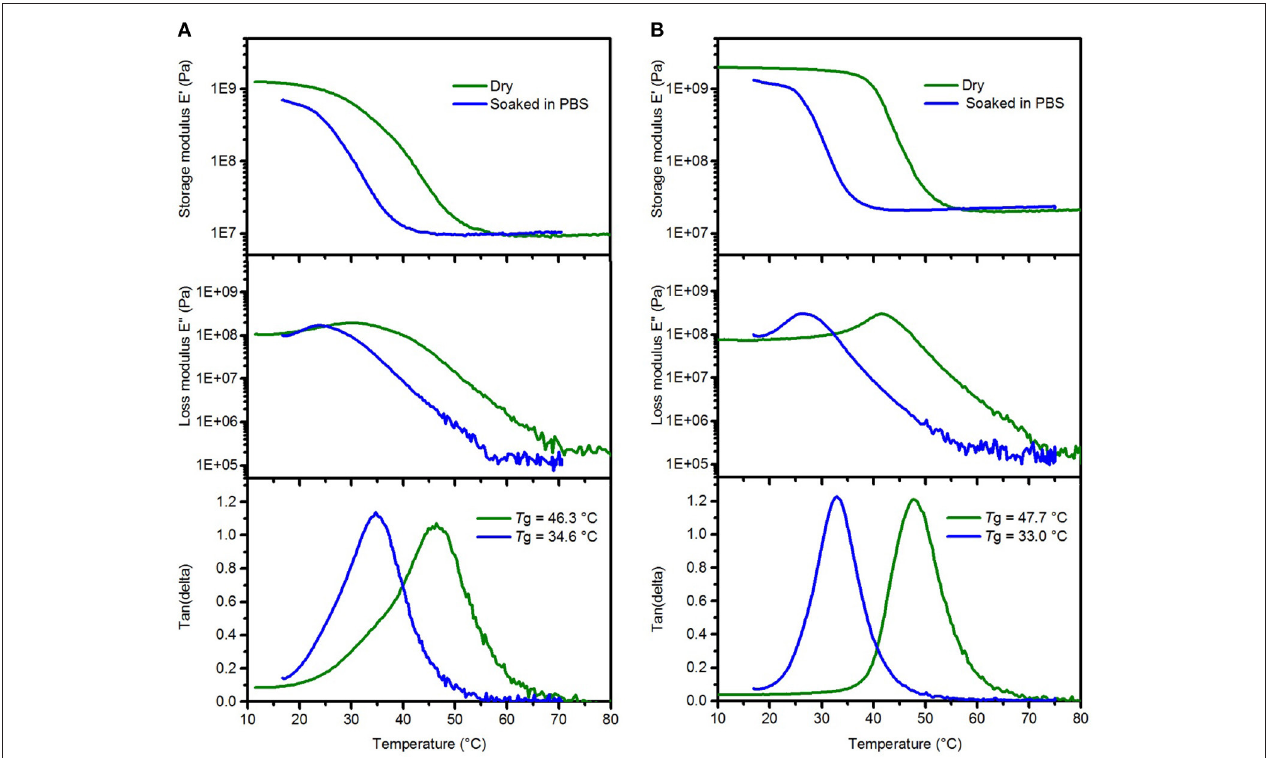
FIGURE 2 | Representative DMA data of SMP-A (A) and SMP-B (B) showing the changes in the storage modulus (top), loss modulus (center), and tan delta (bottom) after softening in PBS,